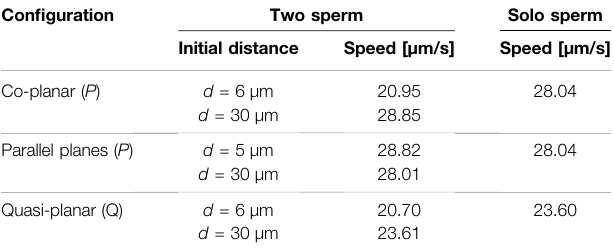
TABLE 2| Swimmingspeedsinfree-spaceforthepreferredplanar( P )beatformin co-planar or parallel beating planes and quasi-planar ( Q ) beat forms, comparing the two sperm con fi guration initialized d apart to the solo sperm.